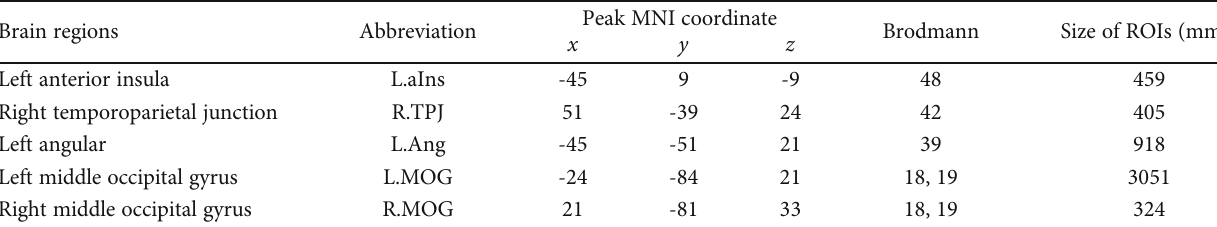
Table 2: Five ROIs determined in global FCD analysis.